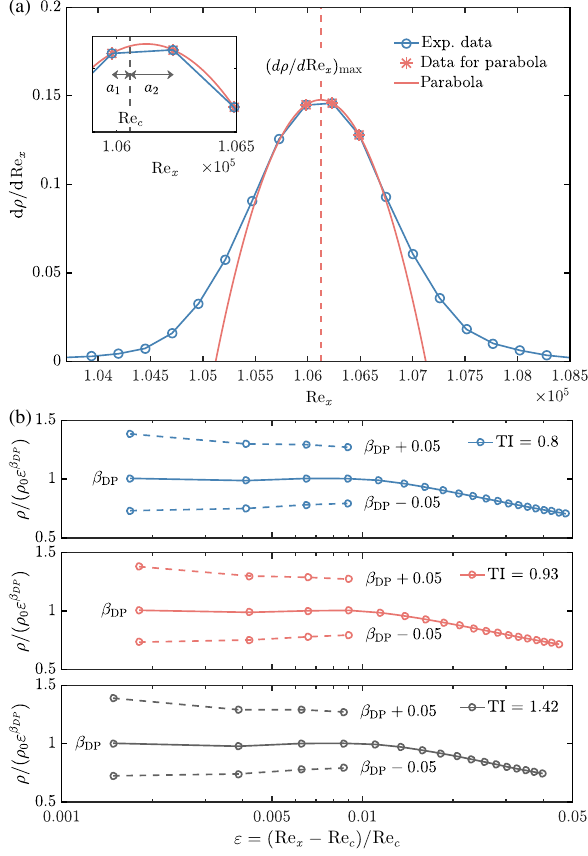
FIG. 5. (a) Illustration of how the critical Reynolds number Re c is determined: (i) One first adjusts a parabola (red line) around the three highest values (stars) of the derivative of the turbulent Þ(cid:2) (circles); (ii) one then performs a best fit, fraction ½ d ρ = ð d Re x expecting the critical Reynolds number Re c lying close to the mathematical maximum (red dashed line) of the parabola respecting the spatial resolution of the experiment. Based on this determined interval, Re c is estimated after Eq. (2). The obtained Re c is marked in the inset (gray dashed line) along with weights a 1 and a 2 used for computation of distributions of ¼ 0 . 8 . laminar cluster sizes at Re c (see Fig. 6). Here, TI th (b) Compensated plots [after Eq. (3)] for each value of the turbulence intensity threshold: fraction of turbulent cells rescaled to the one for 1 þ 1 D directed percolation predictions as a function of the reduced Reynolds number ε